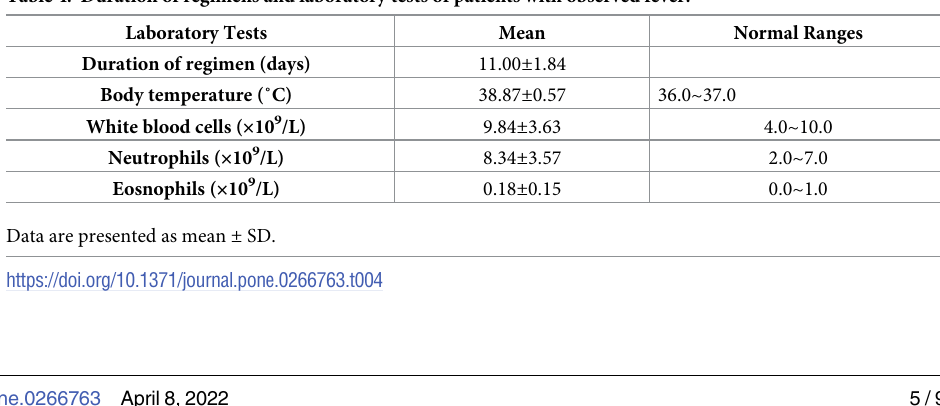
Table 4. Duration of regimens and laboratory tests of patients with observed